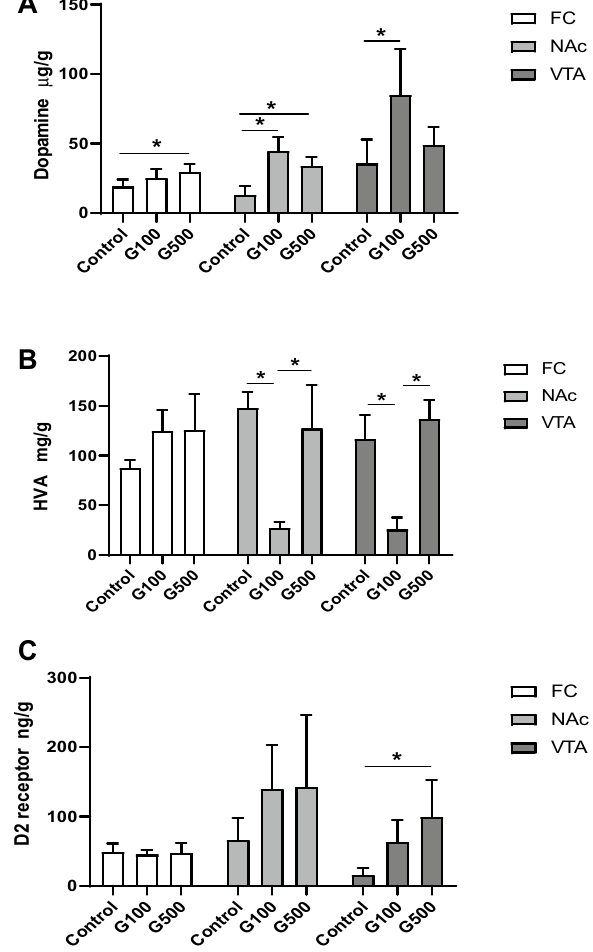
Fig. 3 Effect of low and high dose of Garcinia on Dopamine ( A ), HVA ( B ) and D receptors ( C ) in the frontal cortex (FC), nucleus 2 accumbens (NAc) and Ventral tegmental area (VTA). Data are plot- ted as mean ± SD (n = 7). *Significantly different from